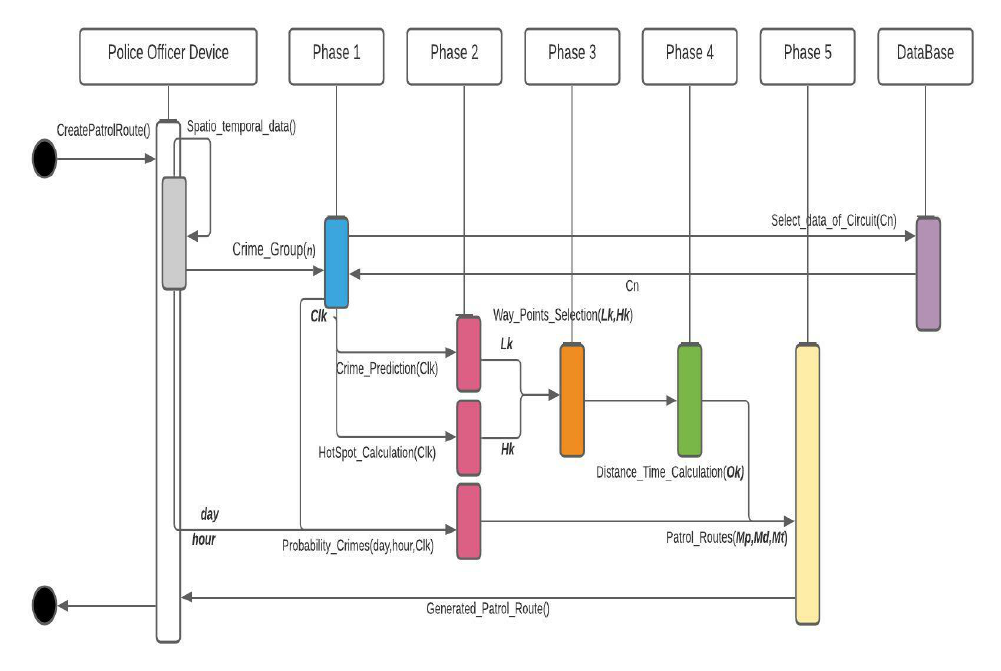
Figure 7. Sequence Diagram UML of Smart Patrol and Crime Prediction Algorithm.